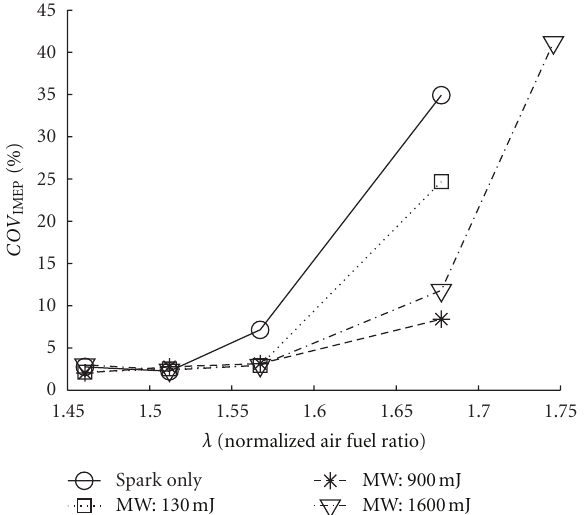
Figure 3: At λ = 1 . 68, adding microwave energy to the spark discharge per cycle decreases occurrence of misfire and partial-burn cycles, thus increasing the total number of complete combustion